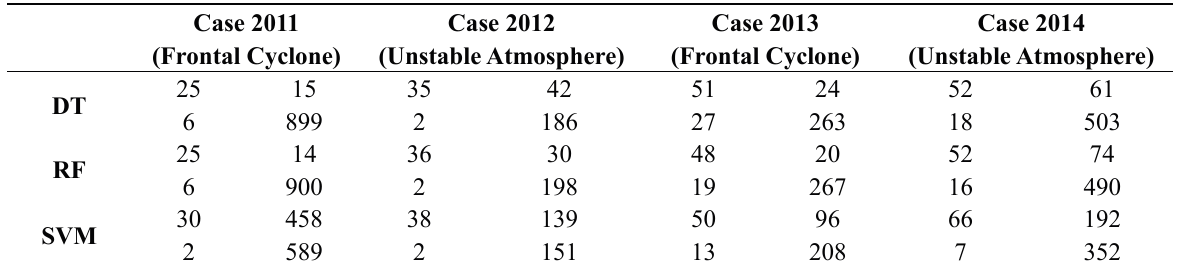
Table 7. Contingency tables generated from the validation of the DT, RF, and SVM models for the four case days. For each model, the four cells below each case name represent H (top- left cell), M (bottom-left cell), FA (top-right cell), and CN (bottom-right cell).